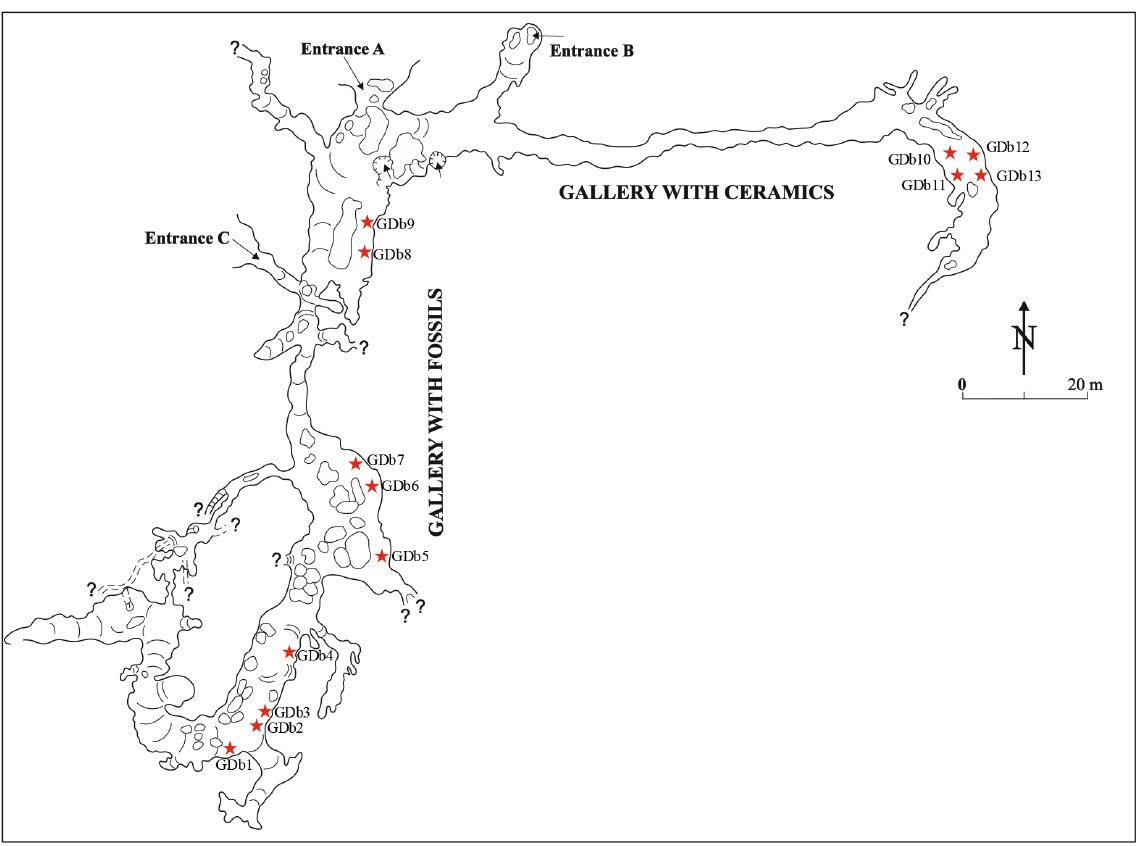
Figure 1. Plan view of the “the Bat Cave” ( Pe¸stera Liliecilor ) from Gura Dobrogei, redrawn based on Dumitrescu et al. (1958). Symbols represent the following: A, B and C – entrances; (cid:63) – access ways to secondary passages and short